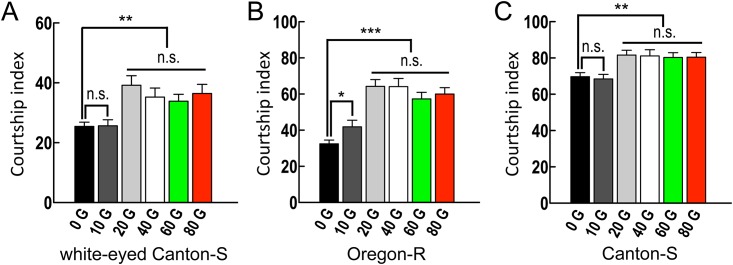
Courtship indices under magnetic fields of various strengths.Courtship activities displayed by different Drosophila strains in various magnetic field strengths (10, 20, 40, 60, and 80 G) in full-spectrum light. The bars show the courtship indices of the three wild-type flies under different magnetic field intensities. (A) white-eyed Canton-S, (B) red-eyed Oregon-R, and (C) red-eyed Canton-S. Each value represents the mean + SEM (n ≥ 8; *p < 0.05, **p < 0.01, and ***p < 0.001; n.s., not statistically significant; ANOVA followed by Tukey’s tests).